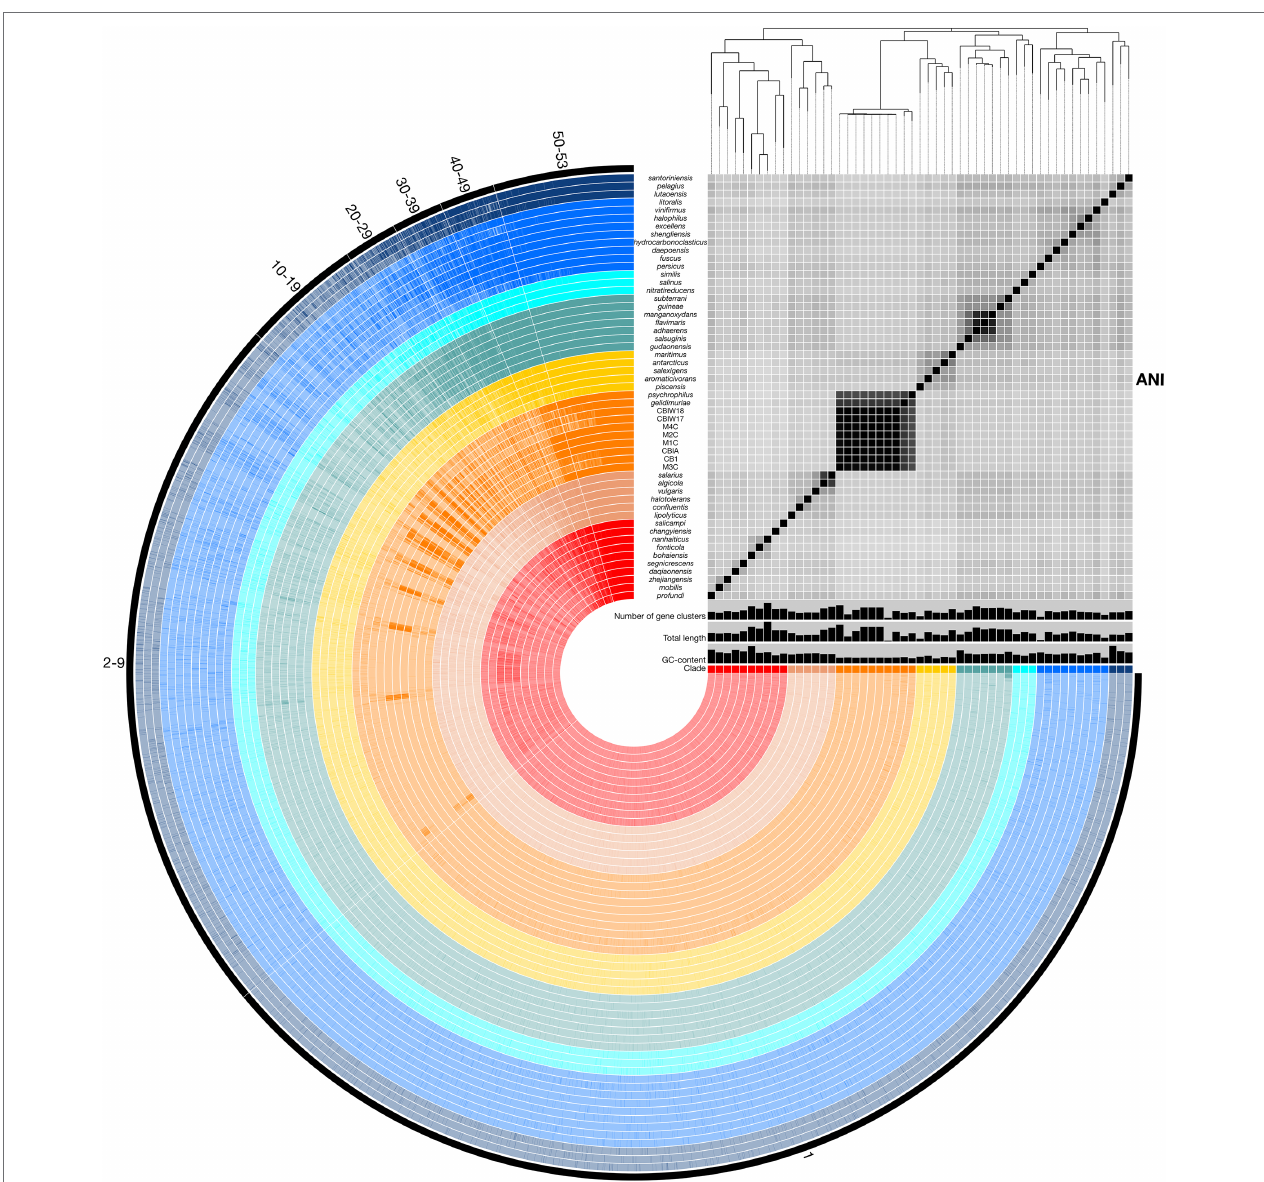
FIGURE 3 | Representation of the Marinobacter pangenome with ANI heatmap. Interior circles are colored according to the clade to which the species belongs. Clades are ordered from I (red) to VIII (dark blue) from the innermost to outermost rings. Brighter lines in these interior circles of the pangenome represent gene cluster presence in each genome. Numbered exterior bars indicate the number of genomes containing gene clusters in each region of the pangenome. The bar graphs display GC content (50%–65%), total genome length (3,000,000–5,358,909 bp), and number of gene clusters (2,500–5,000) per genome. The heatmap represents ANI values between shared regions of each genome (70%–100%). The phylogenetic tree above the heatmap displays the core-gene phylogeny of the pangenome and serves as the basis for clade